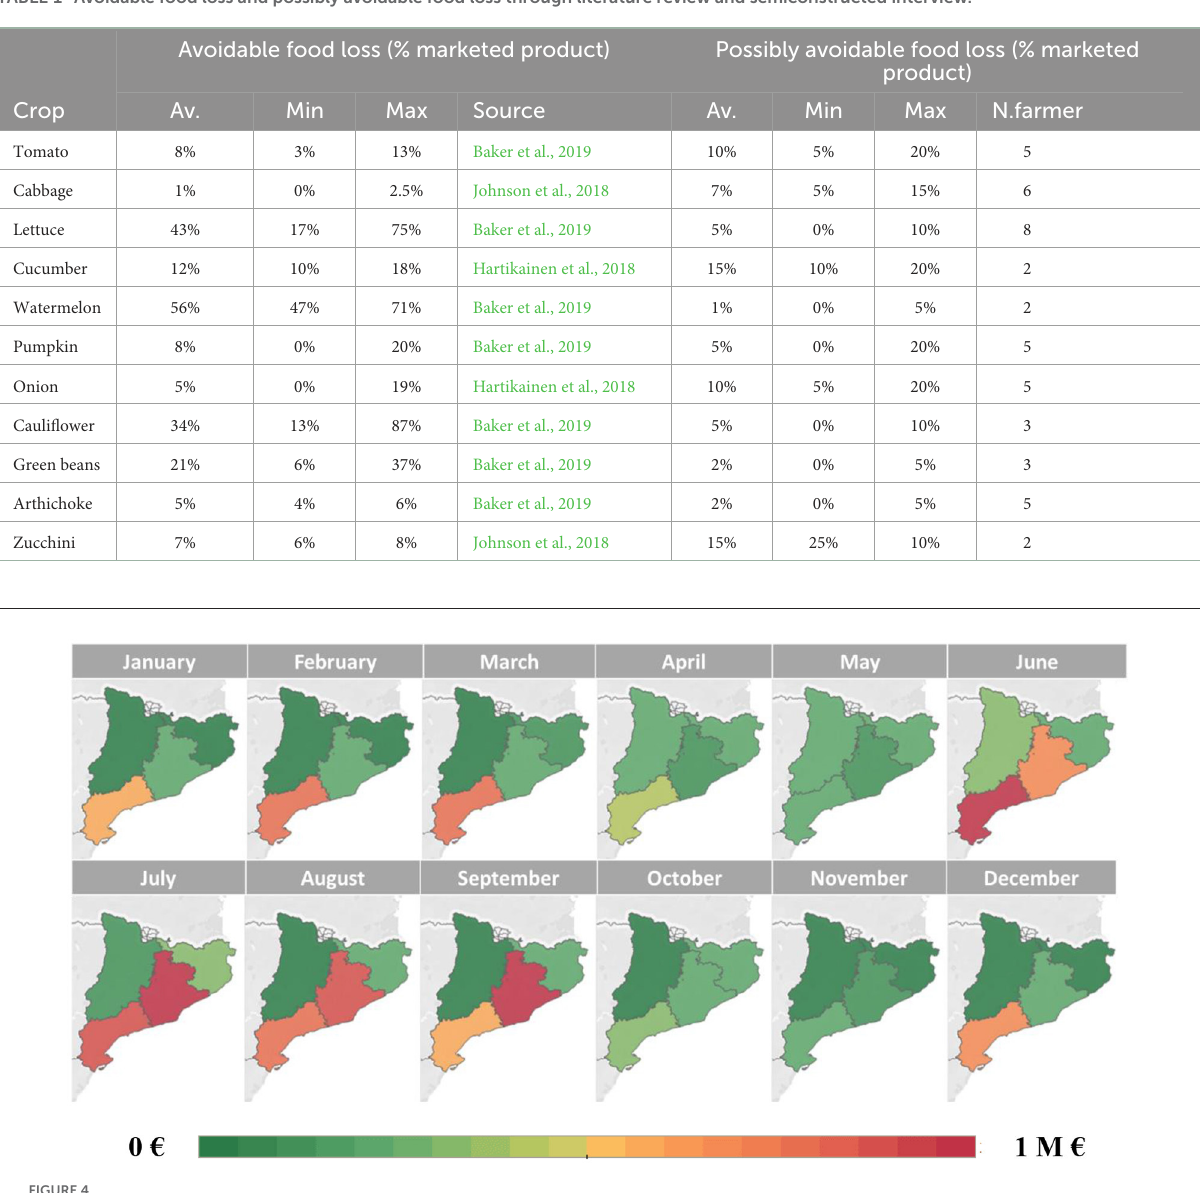
TABLE 1 Avoidable food loss and possibly avoidable food loss through literature review and semiconstructed interview.